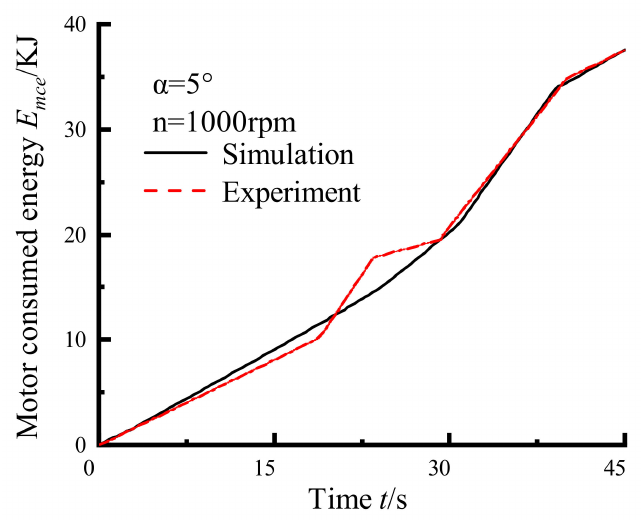
Figure 10. The change in energy consumption with time.